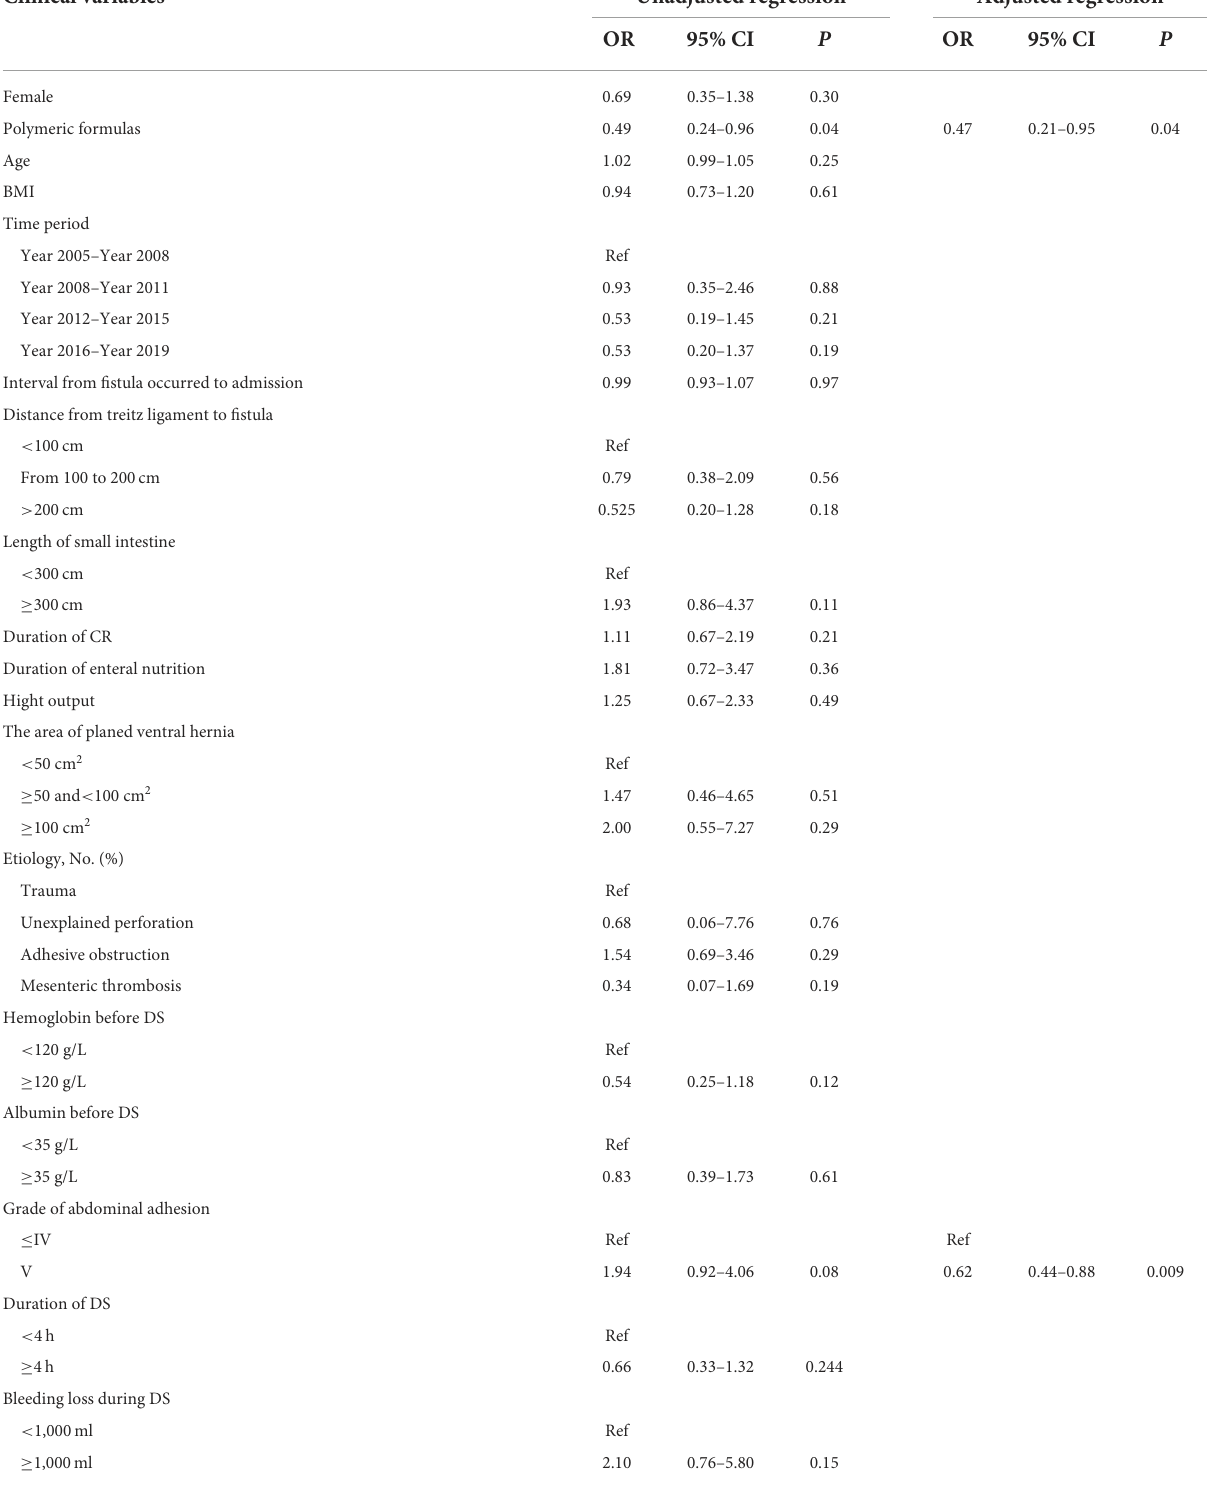
TABLE 2 Logistics regression analysis of the risk factors for defecation before